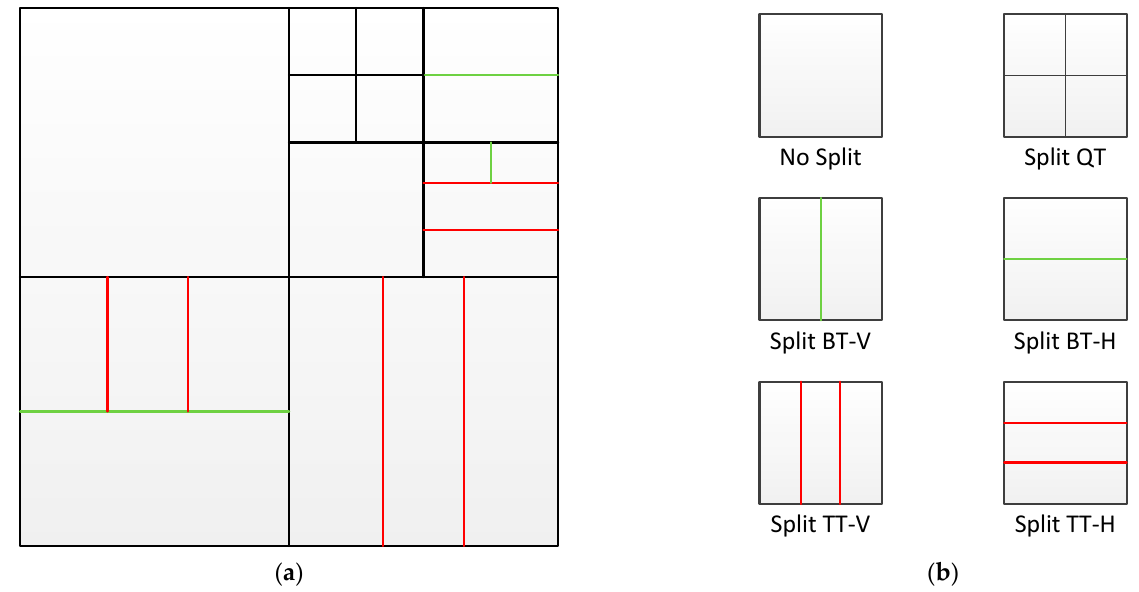
Figure 1. Coding Tree Unit (CTU) partitioning in VVC: ( a ) Take a 64 × 64 CU as an example; ( b ) VVC split types.